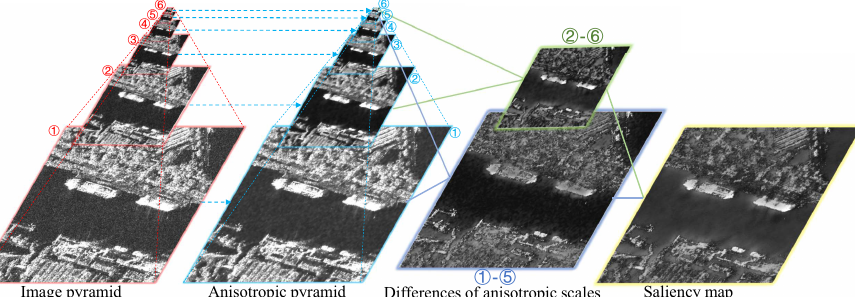
Figure 4. Schematic diagram of the DoAP. Numbers 1–6 denote different scales of the image